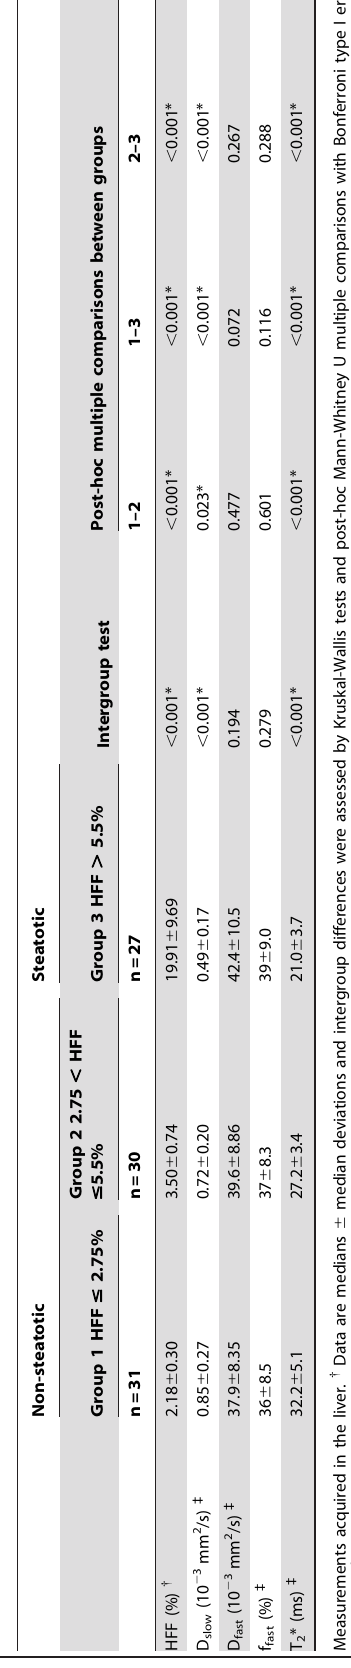
Two models were used to assess the effect of hepatic fat fraction (HFF) on the IVIM-DWI parameters (D slow , D fast and f fast ) or T 2 * measured in 11 patients and 8 segments (n=88). The linear model assumed a linear relationship between HFF and the IVIM-DWI parameters or T 2 * (Y=a N HFF + b). The log-linear model assumed a linear relationship between the logarithmic of HFF and the IVIM-DWI parameters or T 2 * (Y=a N log(HFF) + b). Pearson’s correlations increased when the log-linear model was applied. *Indicates significant correlations.